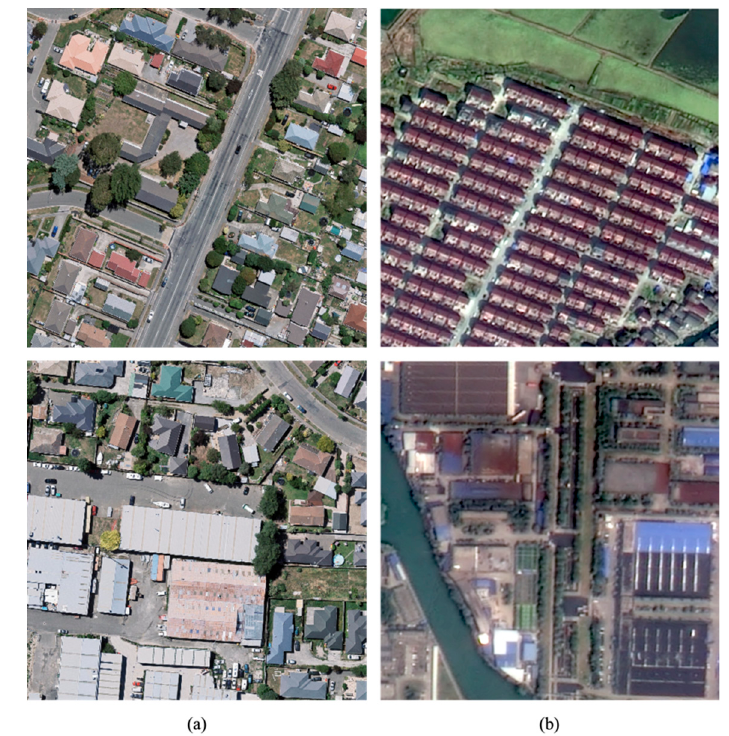
Figure 7. Examples of ( a ) WHU Building Dataset (WHU dataset) and ( b ) Suzhou building dataset (Suzhou dataset), divided by column.